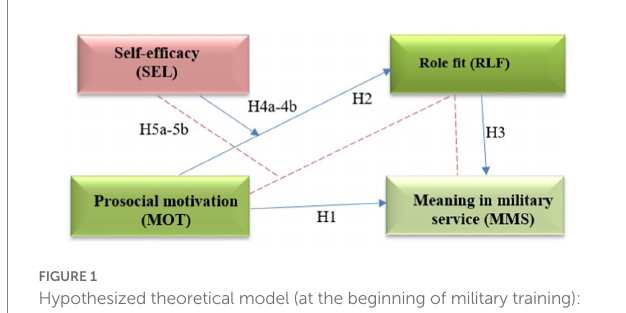
FIGURE 1 Hypothesized theoretical model (at the beginning of military